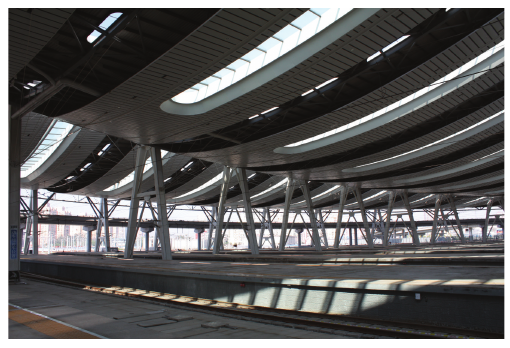
Figure 5: Large station scenario.